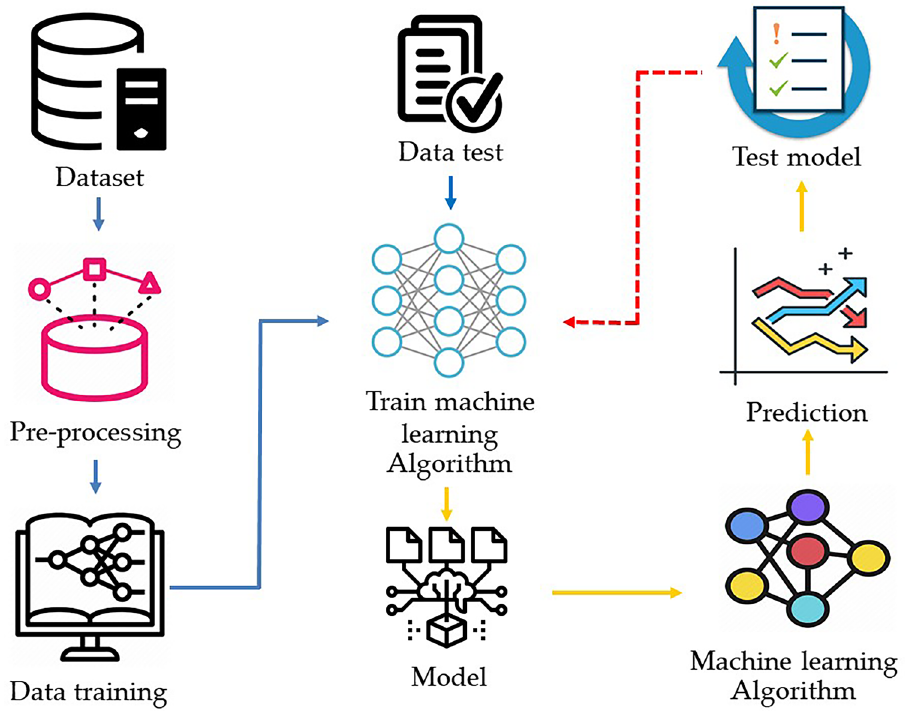
Figure 1. Machine learning predictive